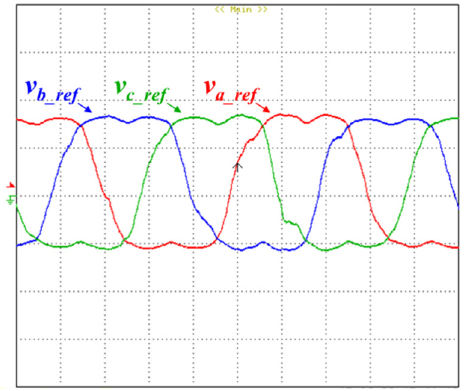
Figure 27. Reference signals for each leg of the power converter when the electric machine operates with a 9 Nm mechanical load (voltage: 5 V/div; time: 5 ms/div).